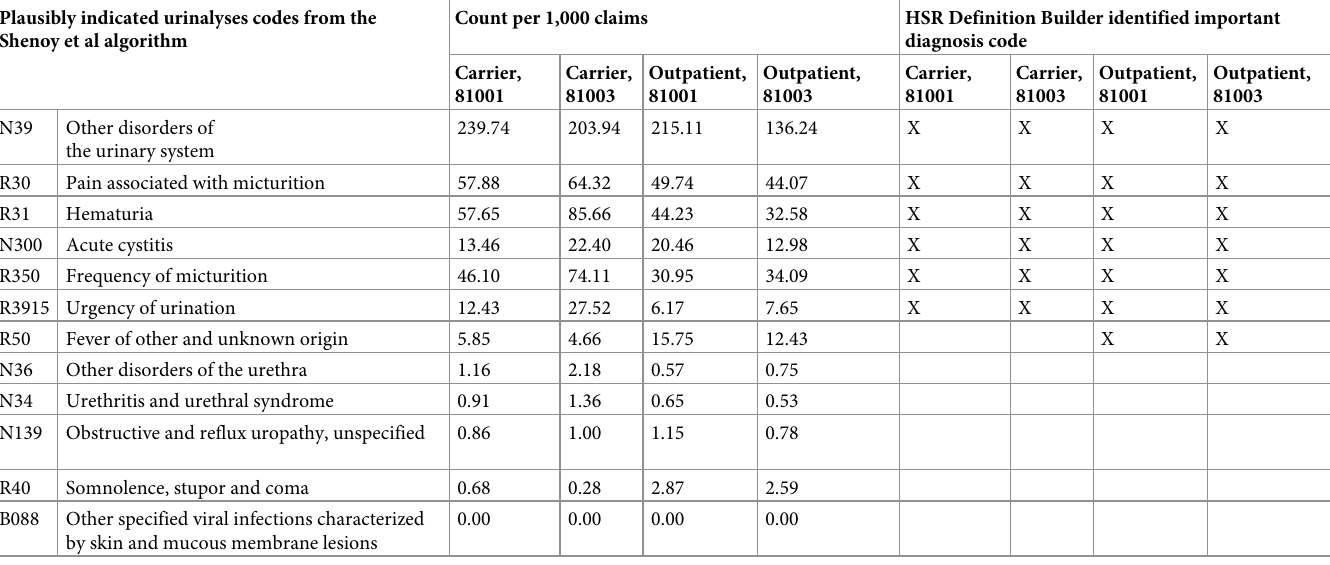
Table 4. Comparing the Shenoy et al [21] algorithm for low-value urinalysis and important diagnosis codes in the HSR Definition Builder application. Plausibly indicated urinalyses codes from the Count per 1,000 Shenoy et al algorithm